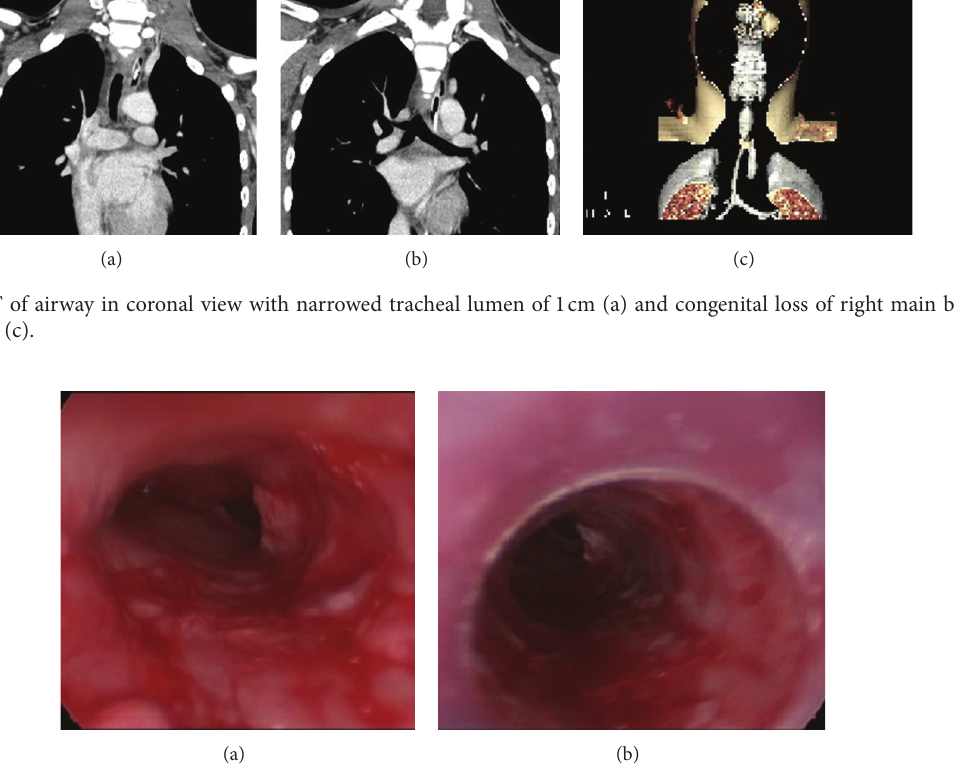
tubal length was gauged under bronchoscope guidance, and the final outer diameter (1.0 cm) was determined through sequential bougienation